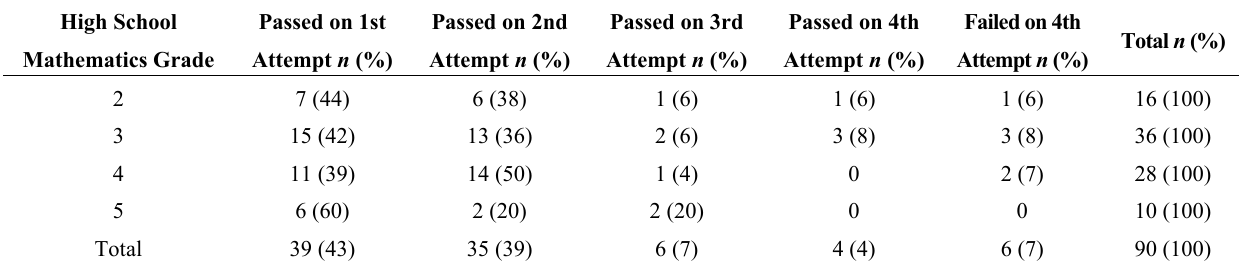
Table 1. The relationship between high school mathematics grade and the number of attempts required to pass the medication calculation test.